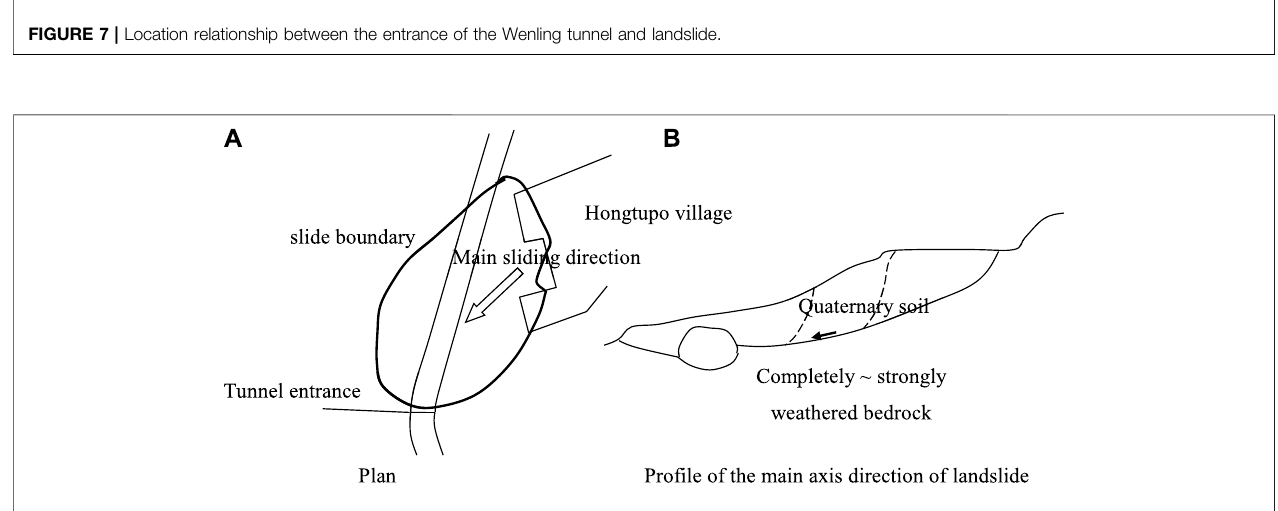
FIGURE 8 | Location relationship between the entrance of the Hongtupo tunnel and landslide.